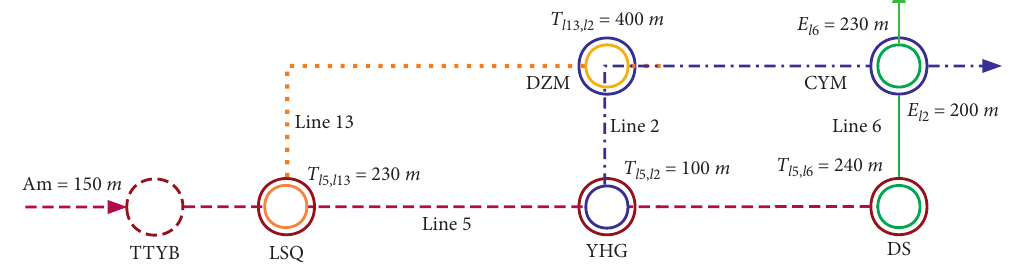
Figure 5: Candidate paths between TTYB and CYM